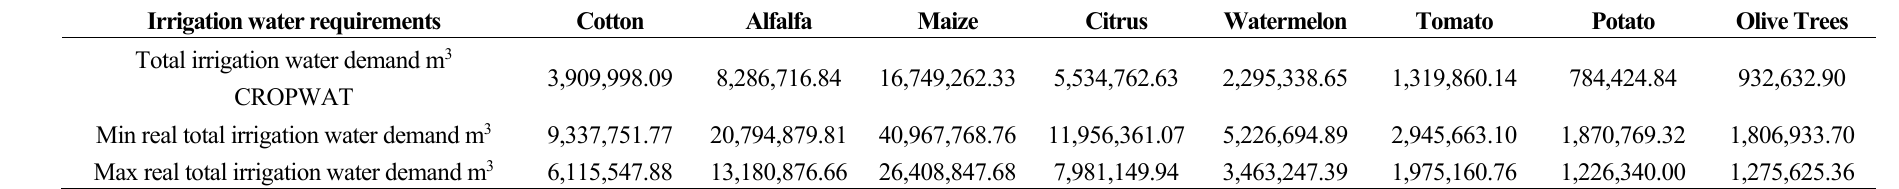
Table 6. Irrigation water requirements computed by CROPWAT 8.0 and the minimum and maximum real irrigation water requirements taking into account the minimum and the maximum irrigation canal losses and the minimum and maximum efficiencies of the irrigation type for the Flokas irrigation scheme.